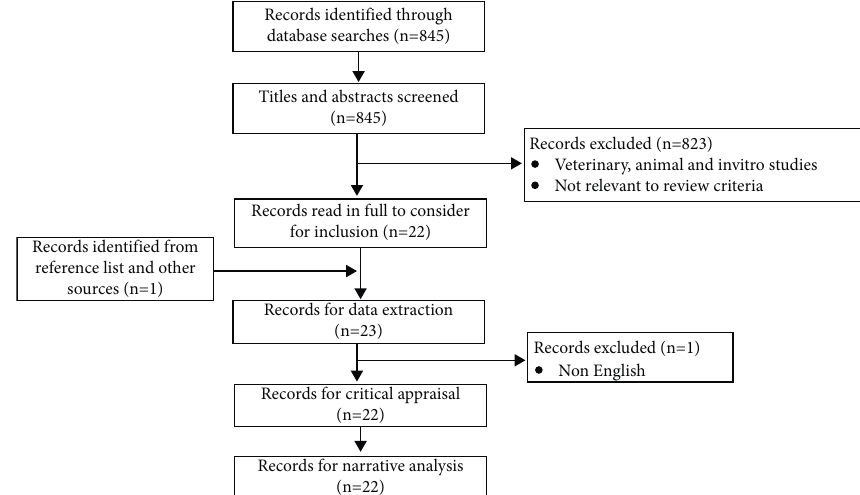
Figure 1: PRISMA (preferred reporting items for systematic reviews and meta-analysis)